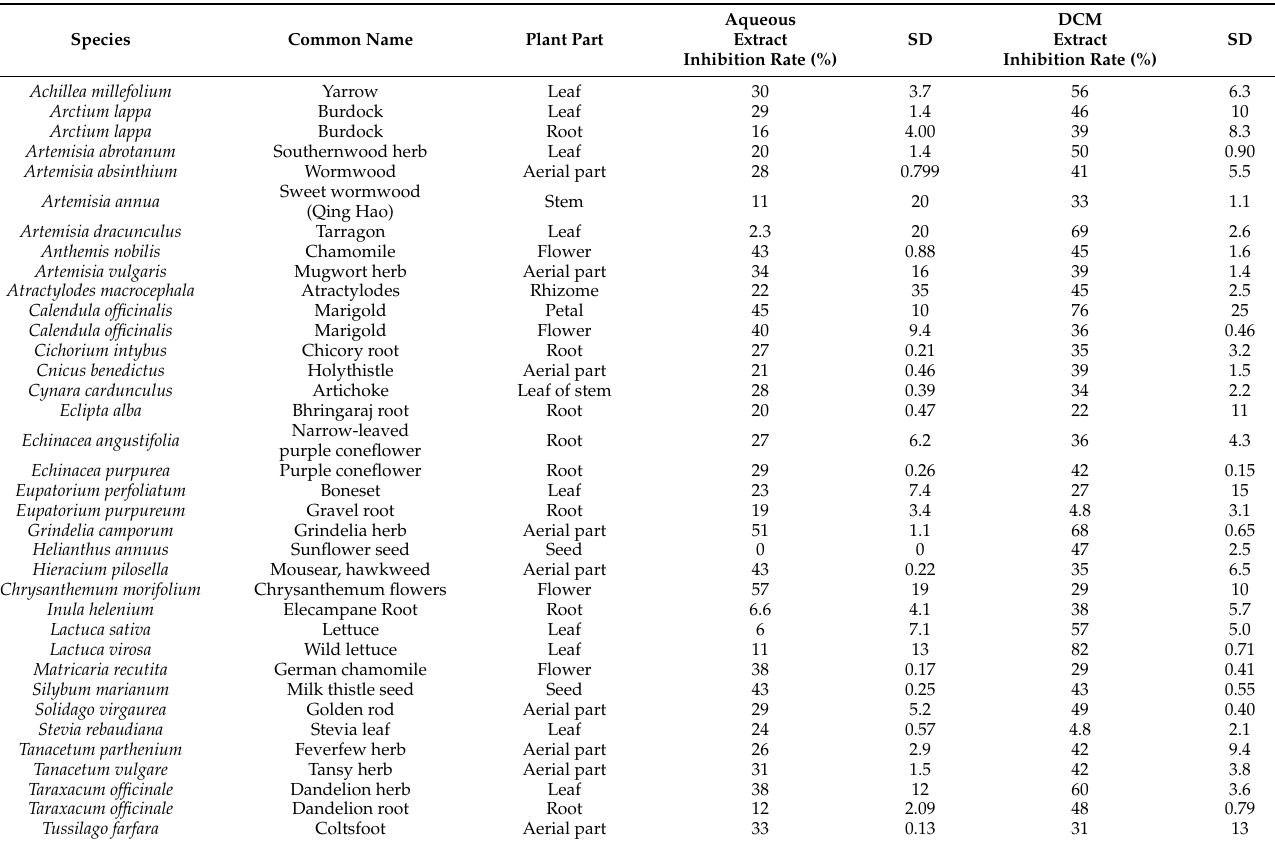
Table 2. Mean attained PNLIP inhibition rate% by the aqueous (10 mg mL − 1 , n = 4) and DCM (250 mg mL − 1 , n = 4) extracts obtained from plants of the Asteraceae